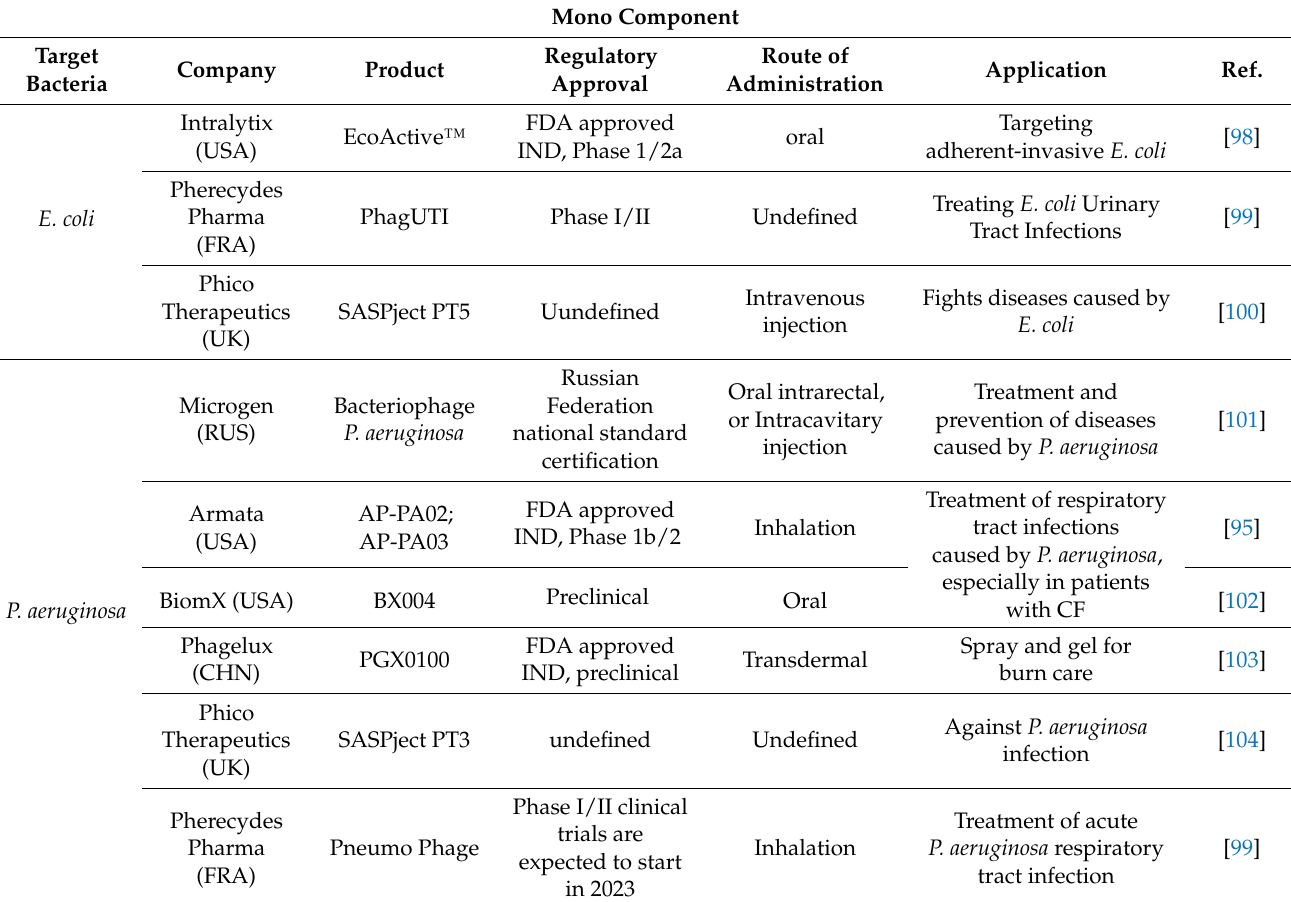
Table 4. Phage products for human